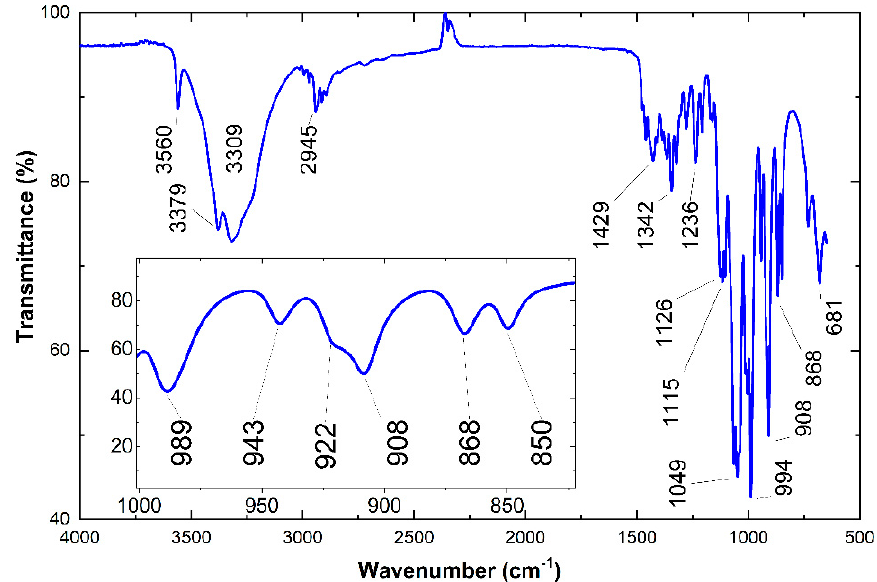
Table 1. Absorption peak signatures of FTIR spectroscopy of sucrose as indicated by Figure 4. Peak Position (cm − 1 )